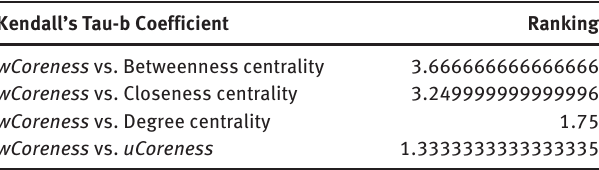
Table 5. Ranking of the Correlation